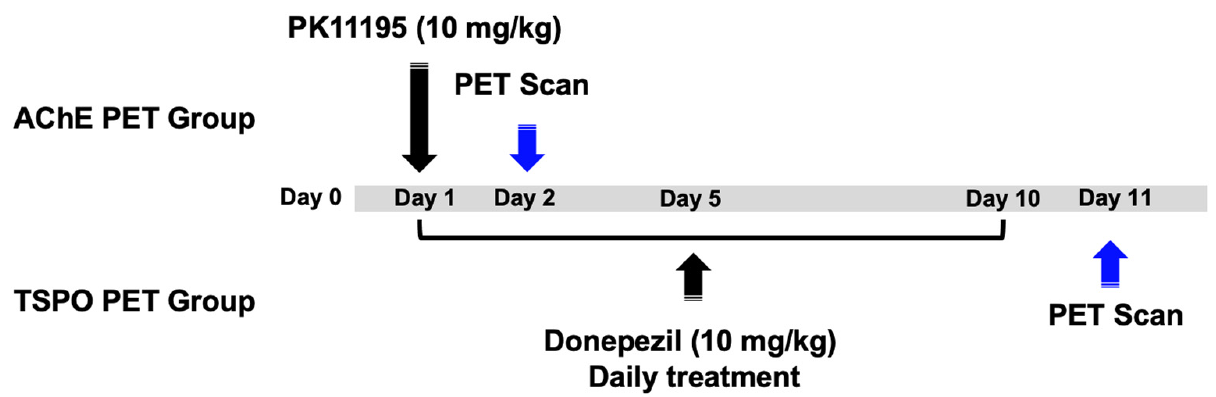
Figure 2. Drug administration and PET studies for the investigation of sequential inflammatory response (each n = 6).